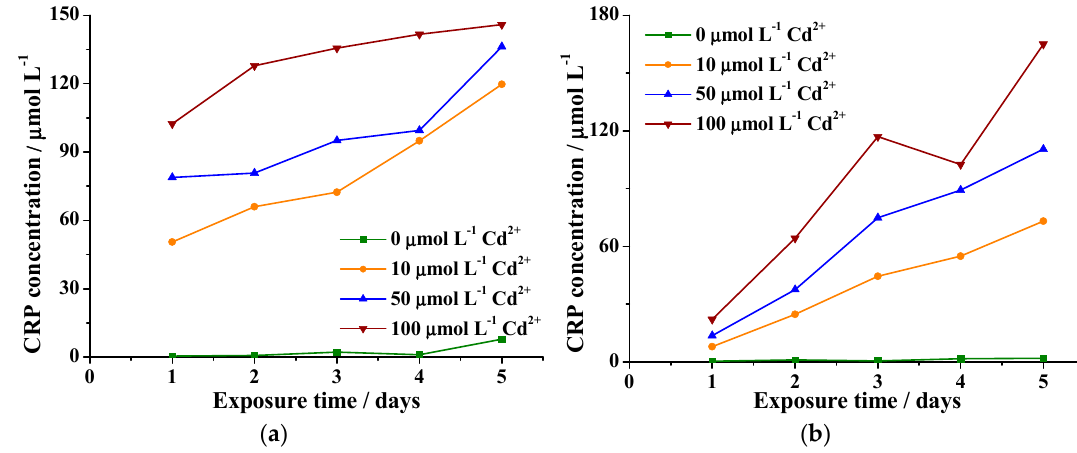
Figure 6. The relationship between cysteine-rich peptide (CRp) concentration and exposure time to different cadmium sulfate concentrations in cells of ( a ) tamarillo and ( b ) tobacco.